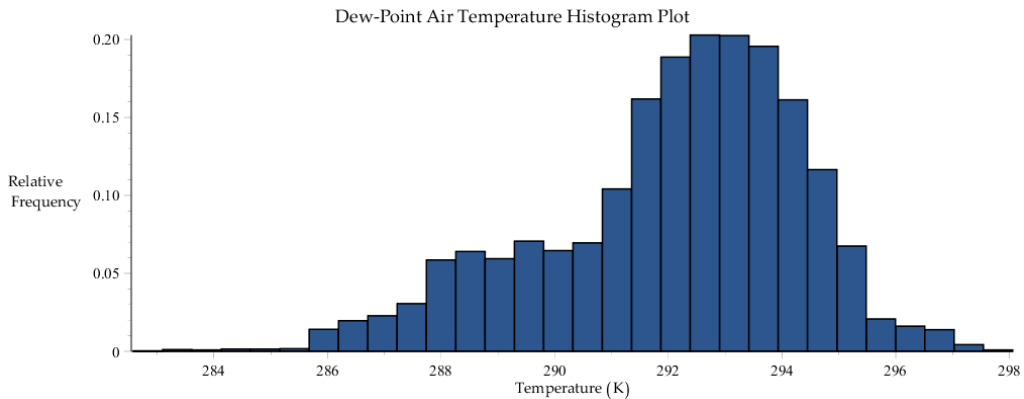
Figure B1. Histogram plot of dry-bulb air temperature data collected by SRNL from F-Area cooling towers.